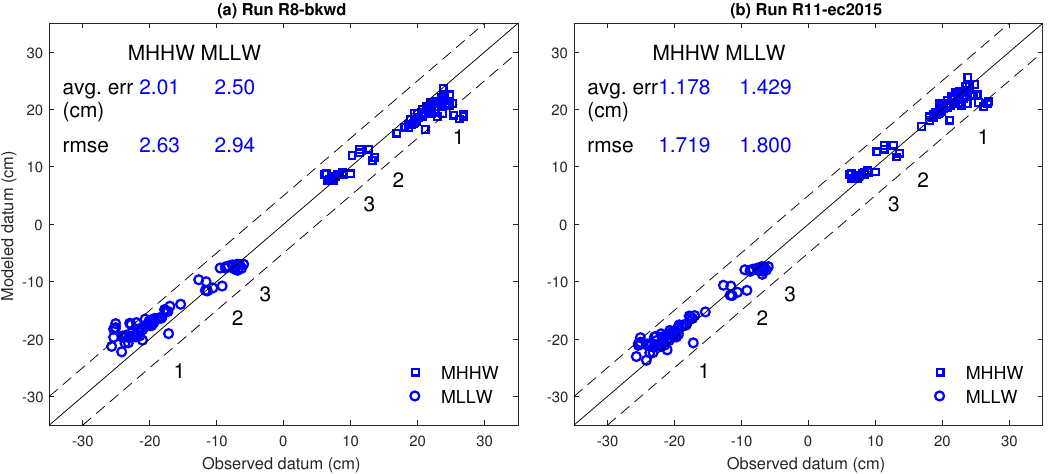
Figure 2. 12 This is a figure, Schemes follow the same formatting. If there are multiple panels, they Figure 12. Sensitivity of modeled datums to offshore boundary conditions using ( a ) EC2001 and should be listed as: ( a ) Description of what is contained in the first panel. ( b ) Description of what is ( b ) EC2015 tidal data base. Tests were conducted using the 2008 model grid with breakwaters added to contained in the second panel. Figures should be placed in the main text near to the first time they are Perdido Bay. The dashed lines indicate the 5-cm error cited. A caption on a single line should be centered.